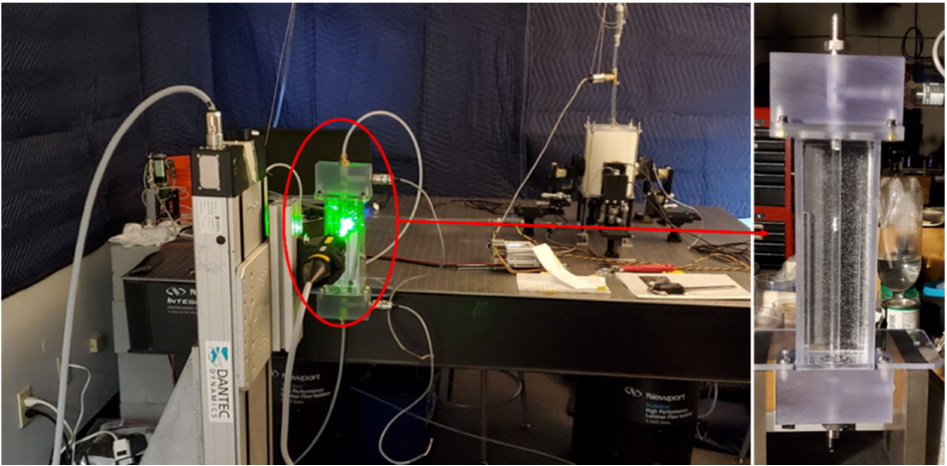
Figure 2. Experimental setup of Laser Doppler Anemometry (LDA) axial velocity measurements for a constricted pipe representing arterial